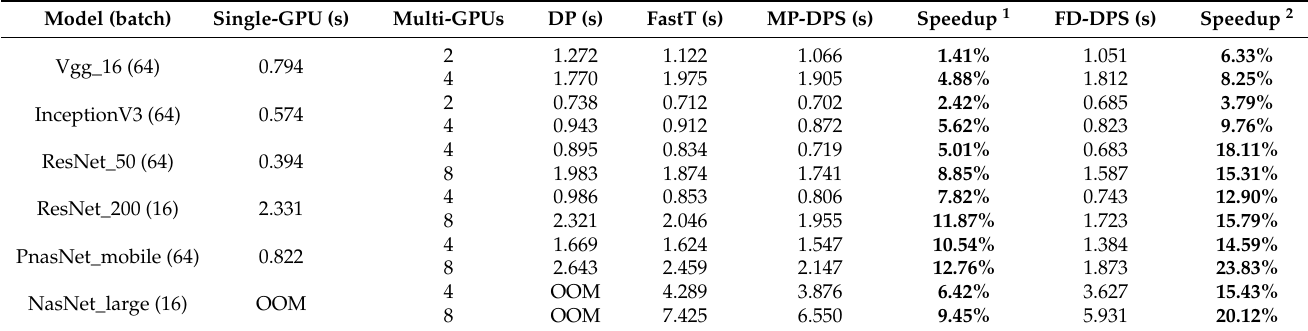
Table 5. Single-round iteration time comparison of FD-DPS and